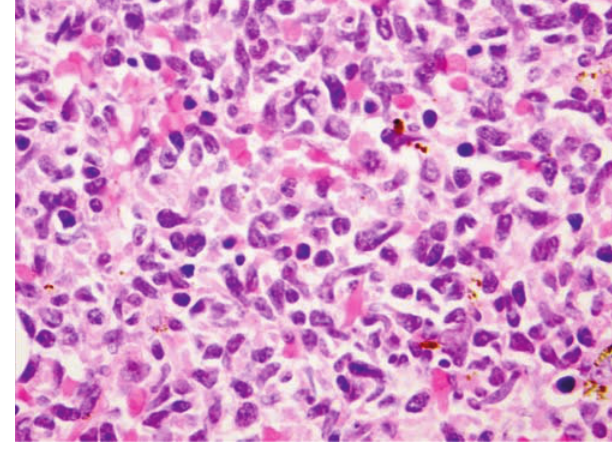
Figure 2. Bone marrow trephine showing medium sized cells with polymorphic, angulated nuclei with moderately basophilic chro- matin and scant eosinophilic cytoplasm. Morphologically these cells resemble atypical lymphocytes. Mitoses are numerous (H&E,